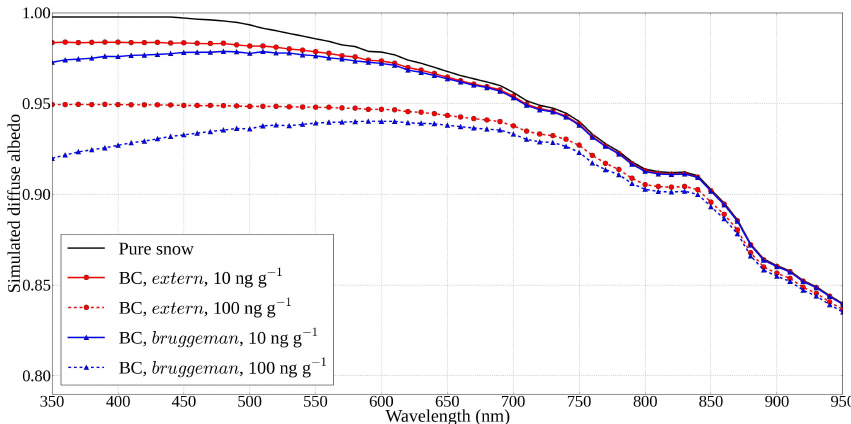
Fig. 5. Diffuse albedo of a semi-infinite snowpack with SSA = 35m 2 kg − 1 , simulated with DISORT from 350 to 950nm. The curves correspond to different assumptions of the snow-BC mixture: black line for pure snow, red circles for external mixture with constant radius ( extern ) and blue triangles for internal mixture with small grains ( bruggeman ). For each assumption, the solid line is for a BC content of 10ngg − 1 and the dashed line is for a BC content of 100ngg − 1